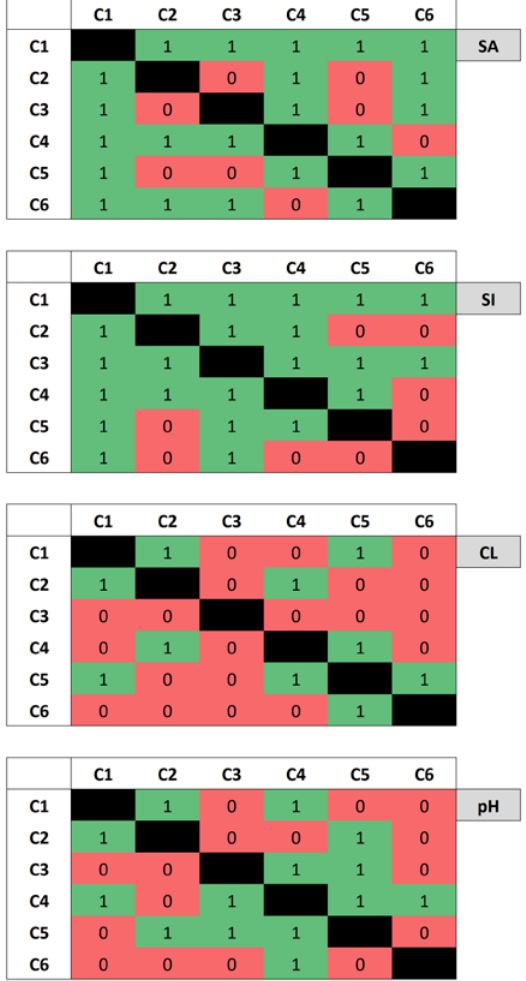
Figure 12. Significance of differences between the cluster mean percentages of SA , SI , and CL content. Red and green cells show not significant and significant difference values.